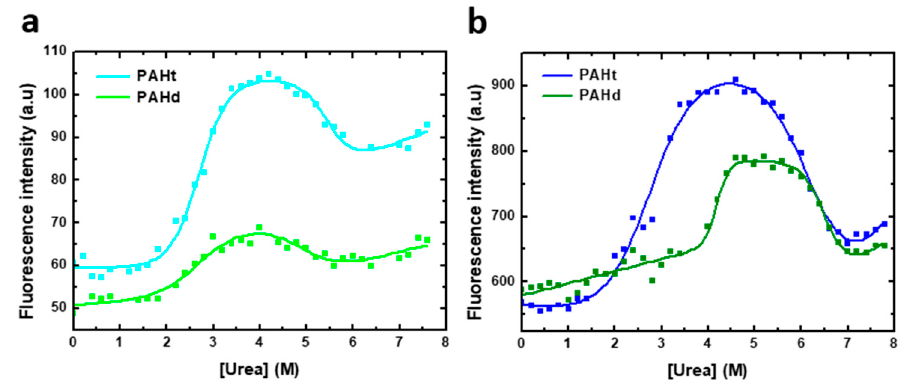
Figure 3. Urea-induced denaturation of human PAH protein at different protein concentrations. Denaturation was monitored by fluorescence intensity at 345 nm (excitation at 295 nm) of ( a ) 0.8 µ M of full-length PAHt construction and truncated PAHd construction and ( b ) 8 µ M of PAHt and PAHd. Continuous lines correspond to the nonlinear fitting curve obtained by using a three-state folding model.